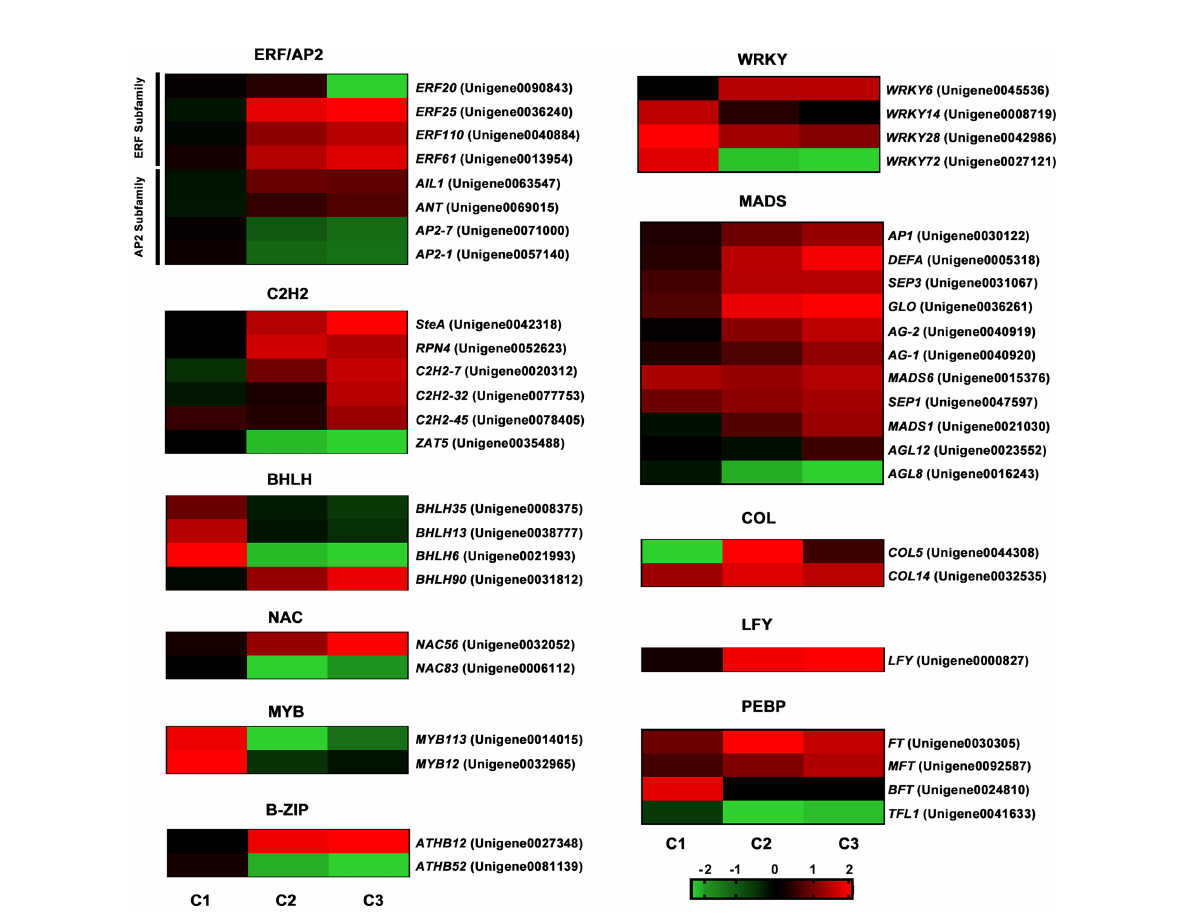
FIGURE 4 Comparative analysis of DEGs during the fl oral transition process in OF and CF habits. Red means the upregulation, and green means the downregulation. C1, C2, and C3 represent WS-S0 vs. WS-S1, AS-S0 vs. AS-S1, and AY-S0 vs. AY-S1